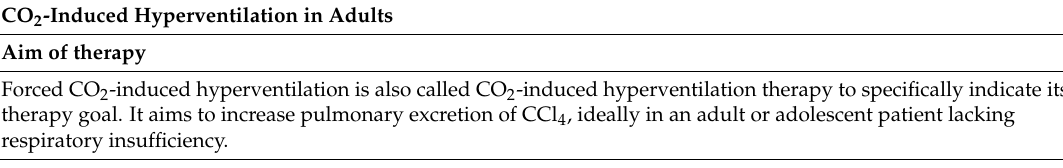
Table 5. CO 2 -induced hyperventilation therapy for acute CCl 4 intoxication.